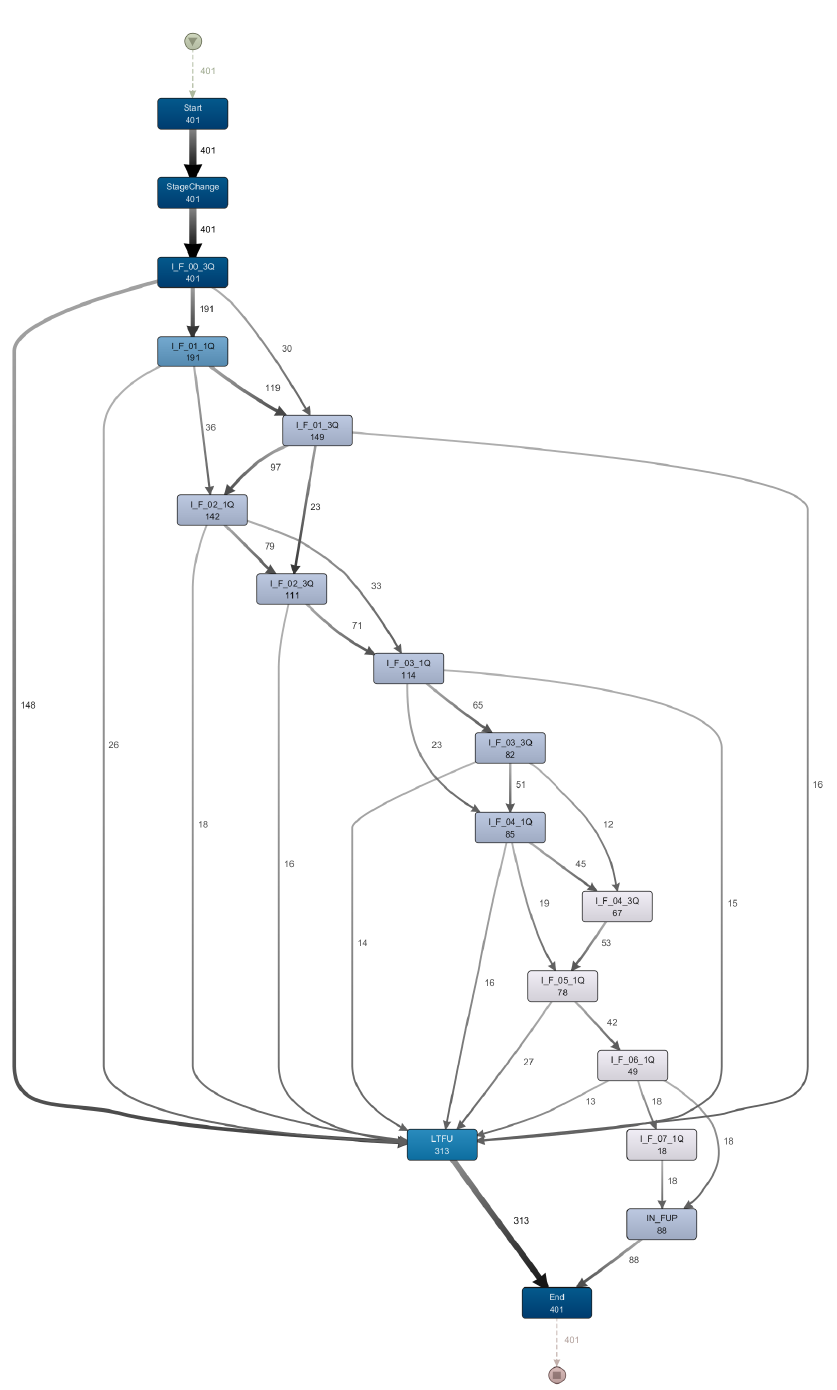
Figure 7. A section of a model created using the process mining tool Disco (Fluxicon BV, Bomanshof, Eindhoven, The Netherlands). The model is based on the stage I log. The tool was set to show all activities (100%) and the most frequent pathways (30%). The colour of the events (dark—more, light—fewer) and the thickness of the pathways (thicker—more) represent the frequency in the